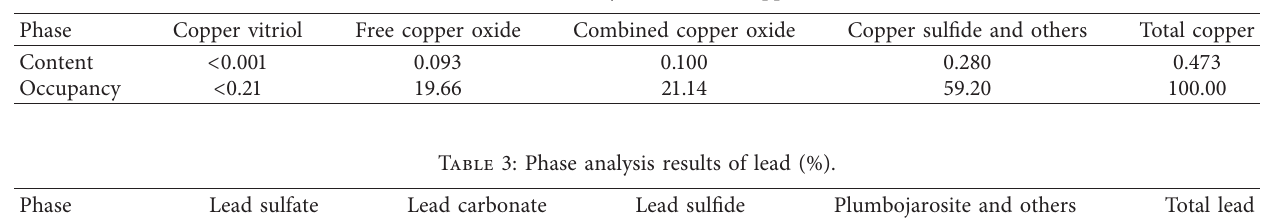
Table 2: Phase analysis results of copper (%).